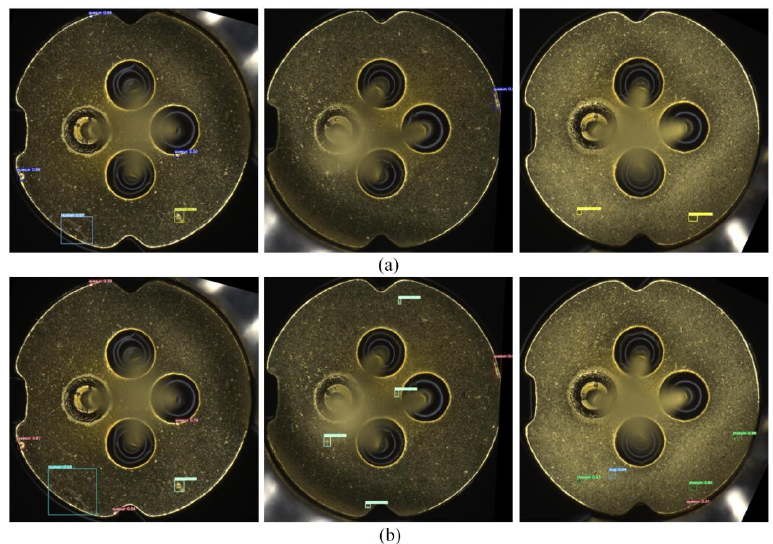
Table 4. Result evaluation of different object detection models.